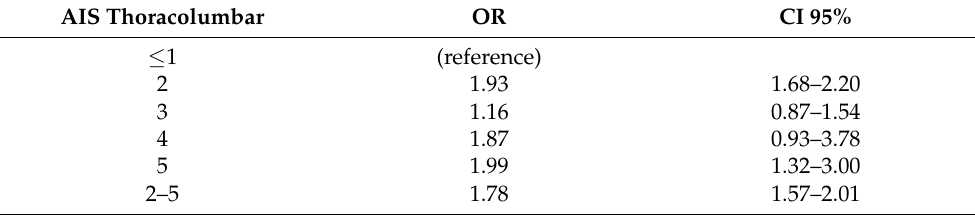
Table 3. Risk of injured pancreas depending on severity of thoracolumbar